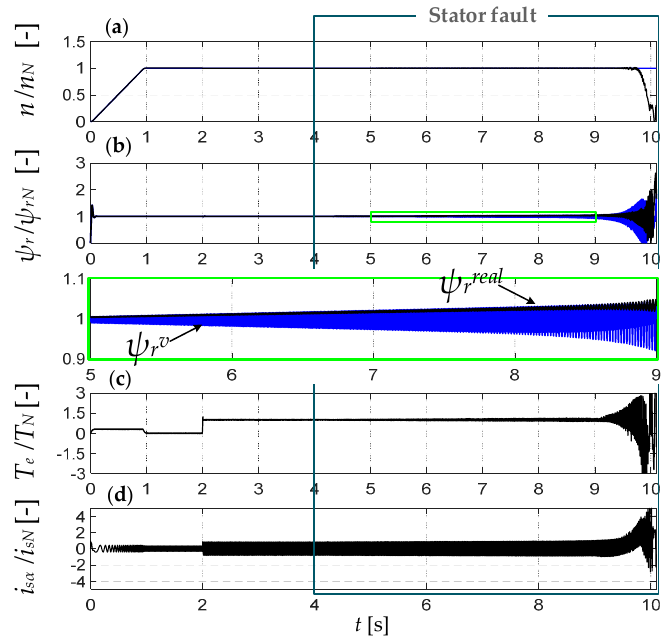
Figure 6. Operation of closed-loop control scheme (DFOC) during ITSC with the VM in the control structure: ( a ) reference and real rotor speed, ( b ) estimated and real rotor flux, ( c ) electromagnetic torque, ( d ) stator current in phase A; (simulation results), ( n ref = n N , T l = T N ).